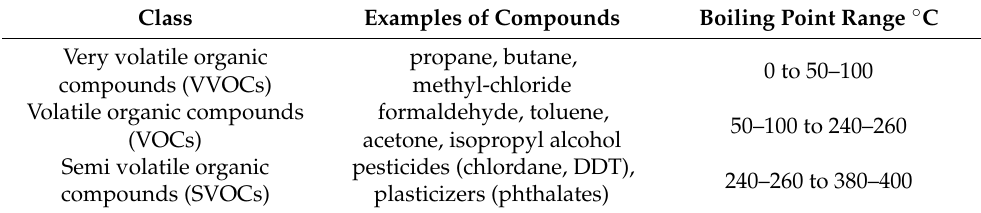
Table 1. Classification of VOCs pollutants. Class Examples of Compounds Boiling Point Range ◦ C Very volatile organic compounds